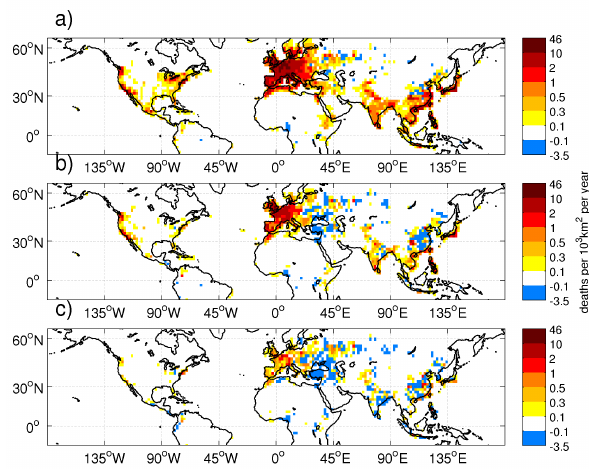
Fig. 3. Sum of excess annual mortality from cardiopulmonary dis- eases and lung cancer due to shipping emissions in simulations (a) ships-2010, (b) geo-wide and (c)